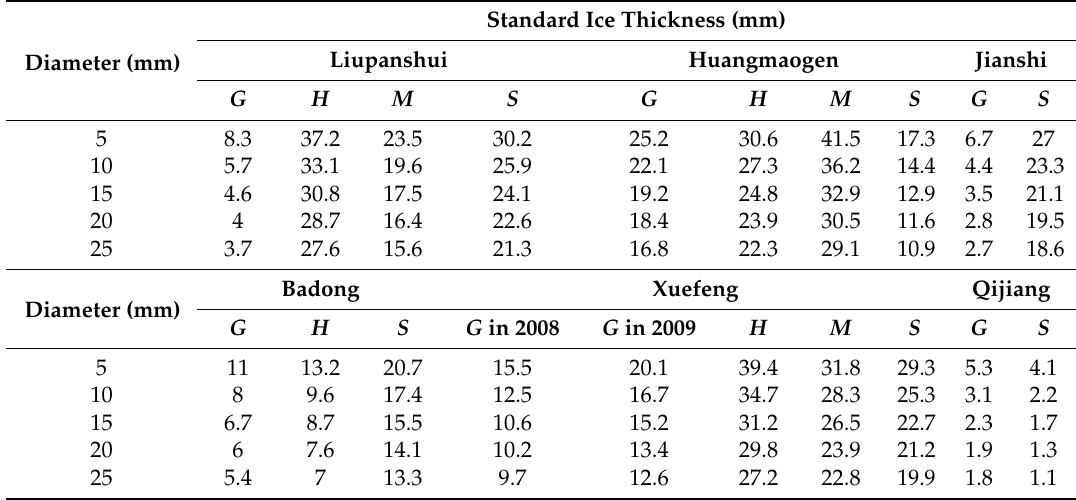
Table 1. Standard ice thickness of conductors for typical ice types tested in Natural test